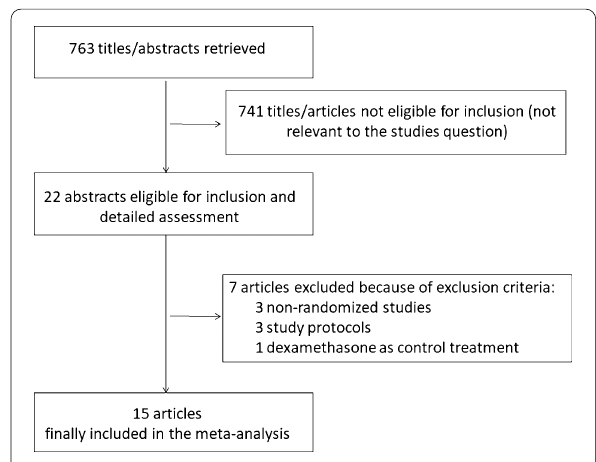
Fig. 1 Flow diagram for study